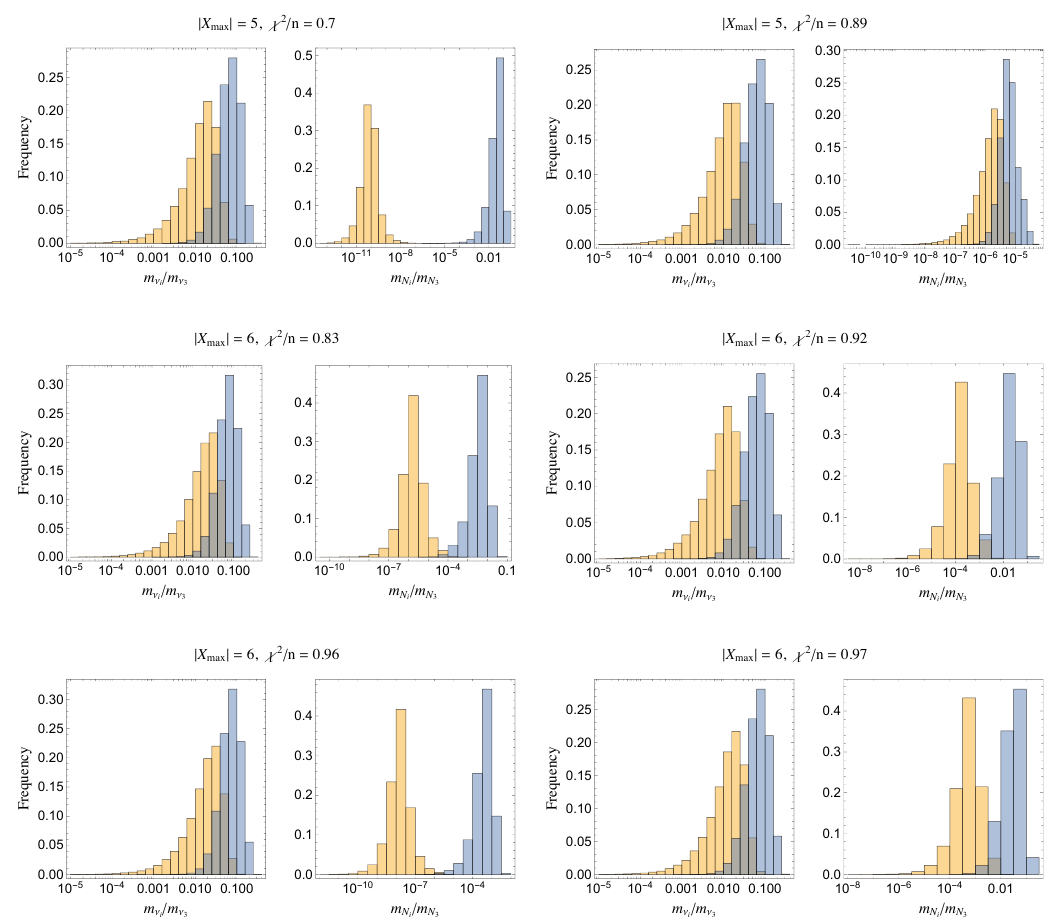
Figure 1: Predictions for the light ( ν the best fit solutions listed in Table 4. The stochastic parameters are chosen randomly from flat distribution of numbers between 0.5 and